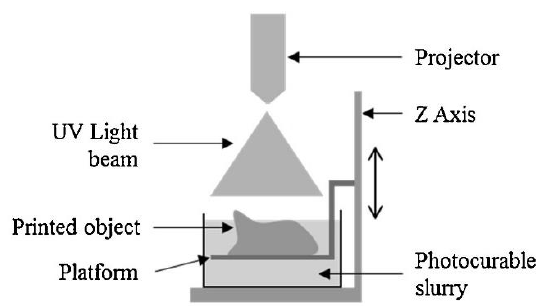
Figure 7. Schematic of sheet lamination process [26]; with permission from Elsevier.